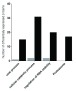
Gene ontology (GO) analysis of iTRAQ-based differentially expressed proteins in VHSV-exposed rainbow trout RBCs.RBCs were exposed to VHSV with a multiplicity of infection (MOI) of 1 at 14°C, and protein quantified at 72 hpe. Proteins were classified into five specific GO-Biological Process categories indicated in the x-axis. The y-axis indicates the number of proteins in each category. Grey bars indicate upregulated proteins and black bars down-regulated proteins.